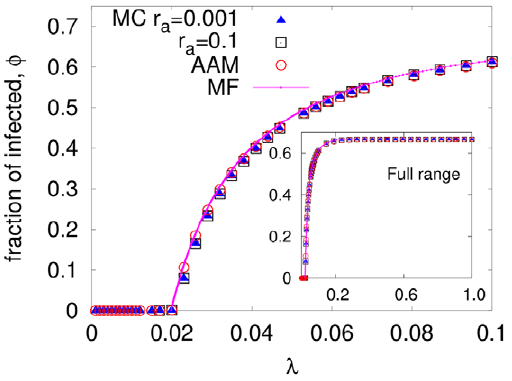
Figure 2. The SIS phase diagram for non-adaptive network. Fraction of infected population versus relative infection rate is plotted the vicinity of the transition point l c = m ~ 0 : 04 and compared with mean-field theories, for N ~ 5000, k ~ 25, m ~ 0 : 5 , and two values of r a . The numerically integrated AAM equations ( Eq 1. in [36]) are shown as open circles (red online), and results from the simple mean-field theory of Eq. 4 are plotted as solid lines (magenta online).